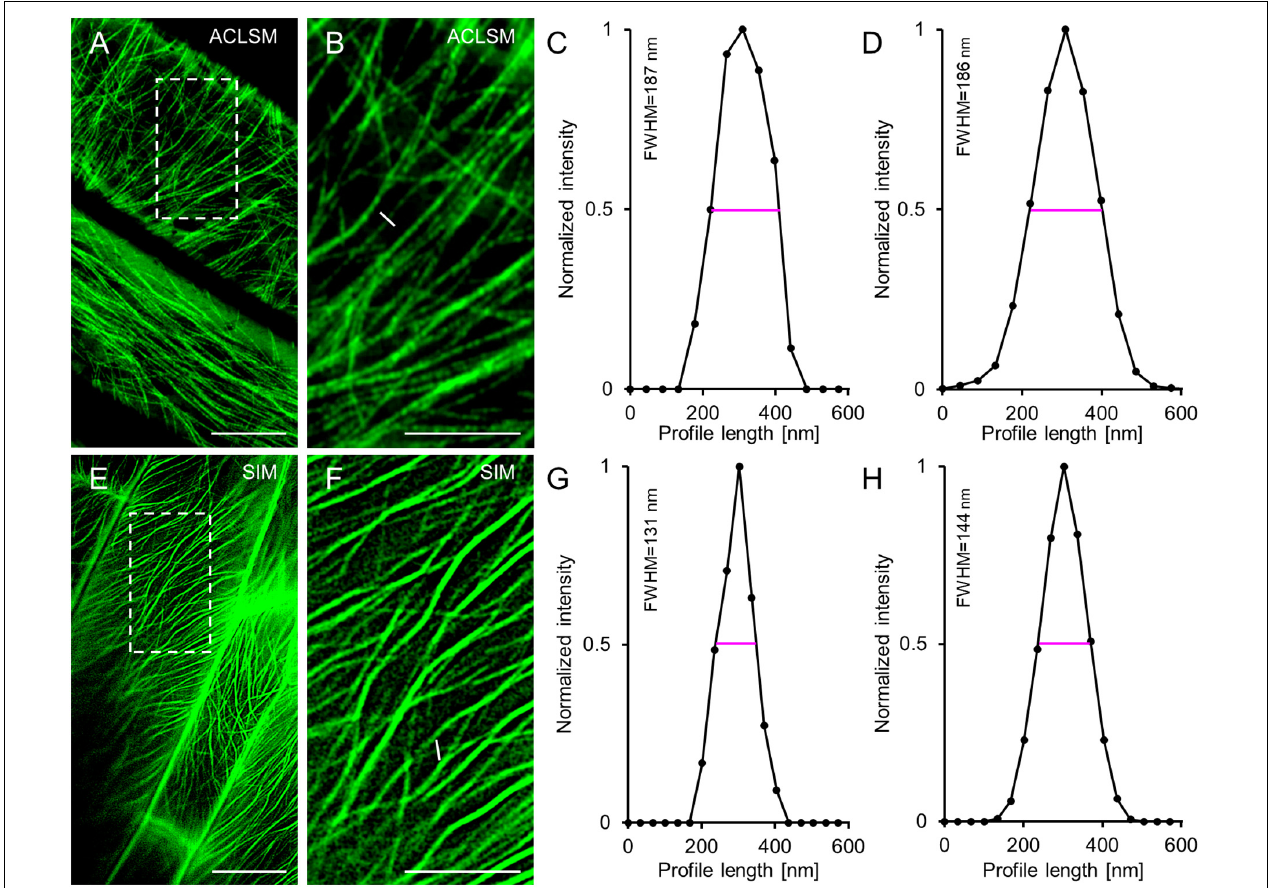
FIGURE 1 | Comparison of ACLSM and SIM in resolving details of TUA6-GFP labeled cortical microtubules in hypocotyl epidermal cells of Arabidopsis labeled. (A) Overview of image from ACLSM (objective 63 × /1.40 NA). (B) Magnified view of the boxed area in (A) . The white line corresponds to a perpendicular profile, for normalized intensity measurement. (C) Graph depicting normalized fluorescence intensity corresponding to the profile shown in (B) . (D) Averaged, coaligned, and normalized intensity profiles of individual TUA6-GFP-labeled microtubules visualized by ACLSM ( N = 43; FWHM – full-width at half maximum). (E) Overview of image from 2D-SIM (objective 63 × /1.40 NA). (F) Magnified view of the boxed area in (E) . The white line in (F) shows a profile, used for normalized intensity measurement. (G) Representative plot of a normalized fluorescence intensity corresponding to the profile drawn in (F) . (H) Averaged, coaligned, and normalized intensity profiles of individual TUA6-GFP-labeled microtubules visualized with 2D-SIM ( N = 44). Scale bars = 10 µ m (A,E) , or 5 µ m (B,F) ,